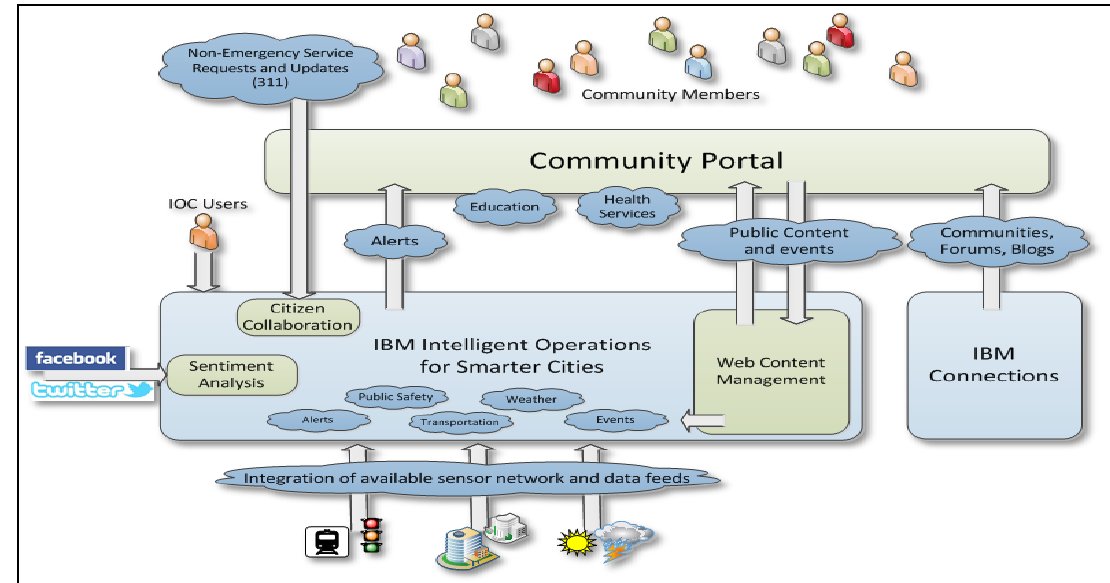
Figure 2. The CitizenReach platform being deployed in Waterfront Toronto communities. Source: elementblue